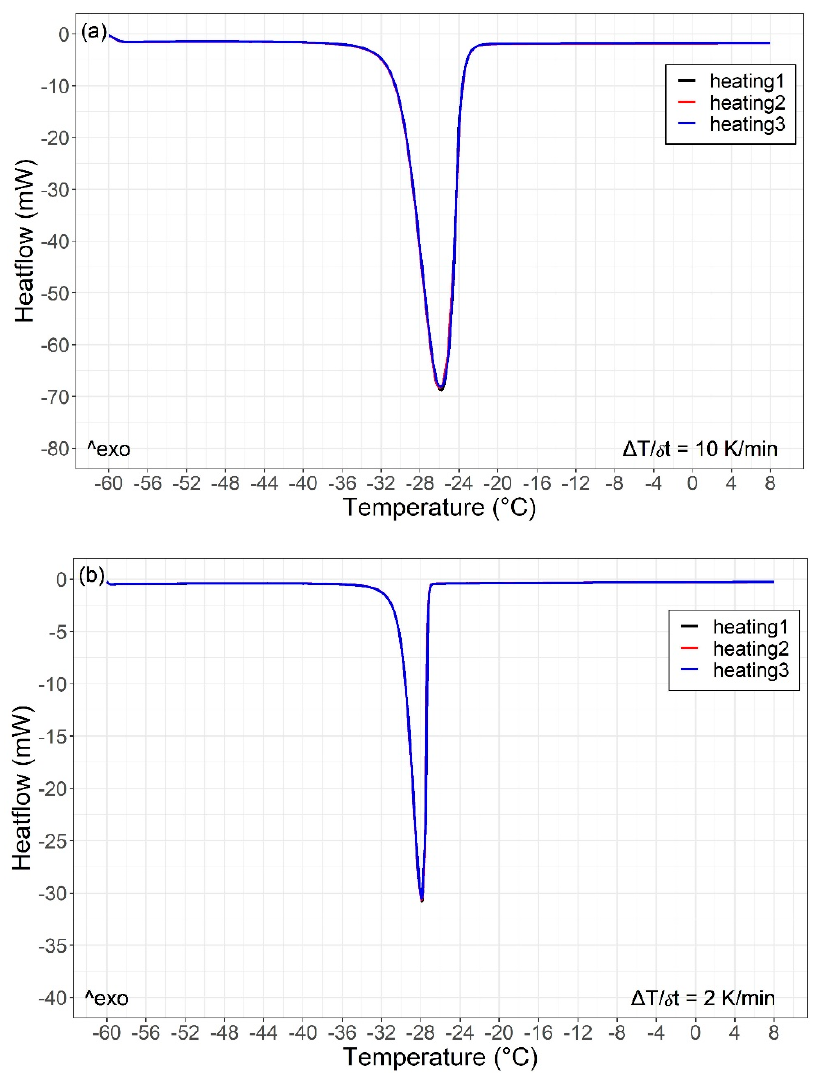
Figure 1. Example of DSC melting curves resulting from measurements with ( a ) 10 K/min to determine the phase change enthalpy and ( b ) 2 K/min to determine phase change temperature. In both cases, all three repetitions are plotted in the same graph, showing the very consistent melting behavior that n-decane presented.